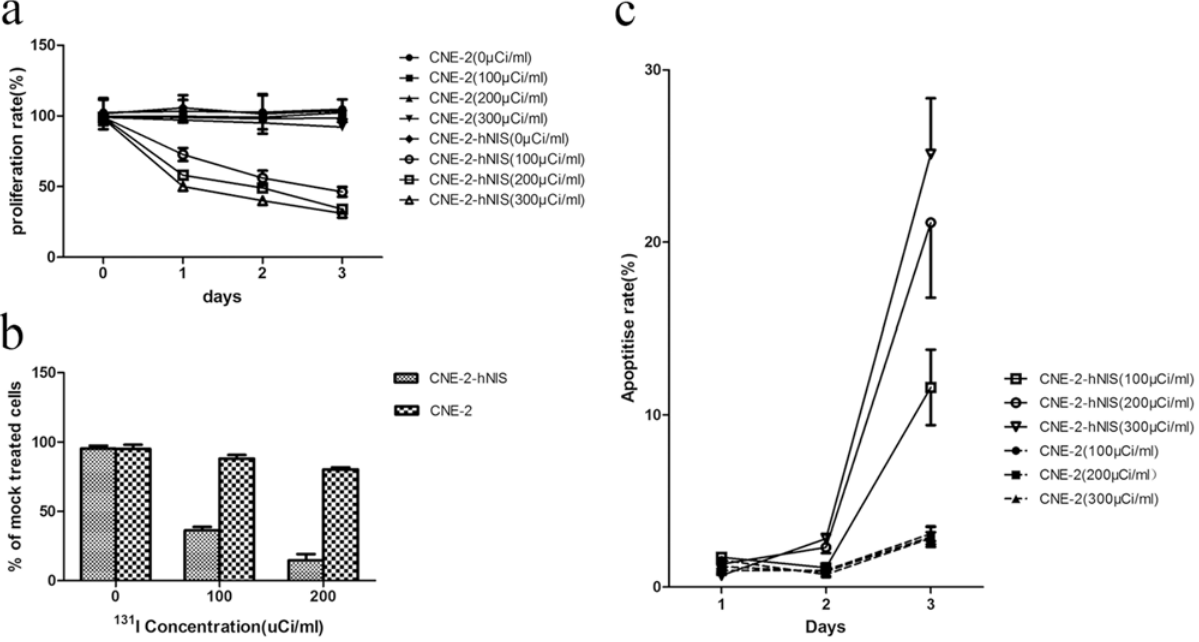
Figure 2. The toxic effects of 131 I in vitro. (a) Assessment of cell proliferation in 0 to 3 days by CCK-8 of CNE-2-hNIS and CNE-2 cells after 7 h of incubation with 100 to 300 μ Ci/ml Na 131 I. Results are expressed as mean and SD of at least three independent determinations. (b) Clone formation of CNE- 2-hNIS and CNE-2 cells in the in vitro clonogenic assay after 7 h of incubation with 0 to 200 μ Ci/ml Na 131 I. For ease of comparison, values are depicted as percent of mock-treated cells. (c) Assessment of cell apoptosis in 0 to 3 days by Annexin V-PI of CNE-2-hNIS and CNE-2 cells after 7 h of incubation with 100 – 300 μ Ci/ml Na 131